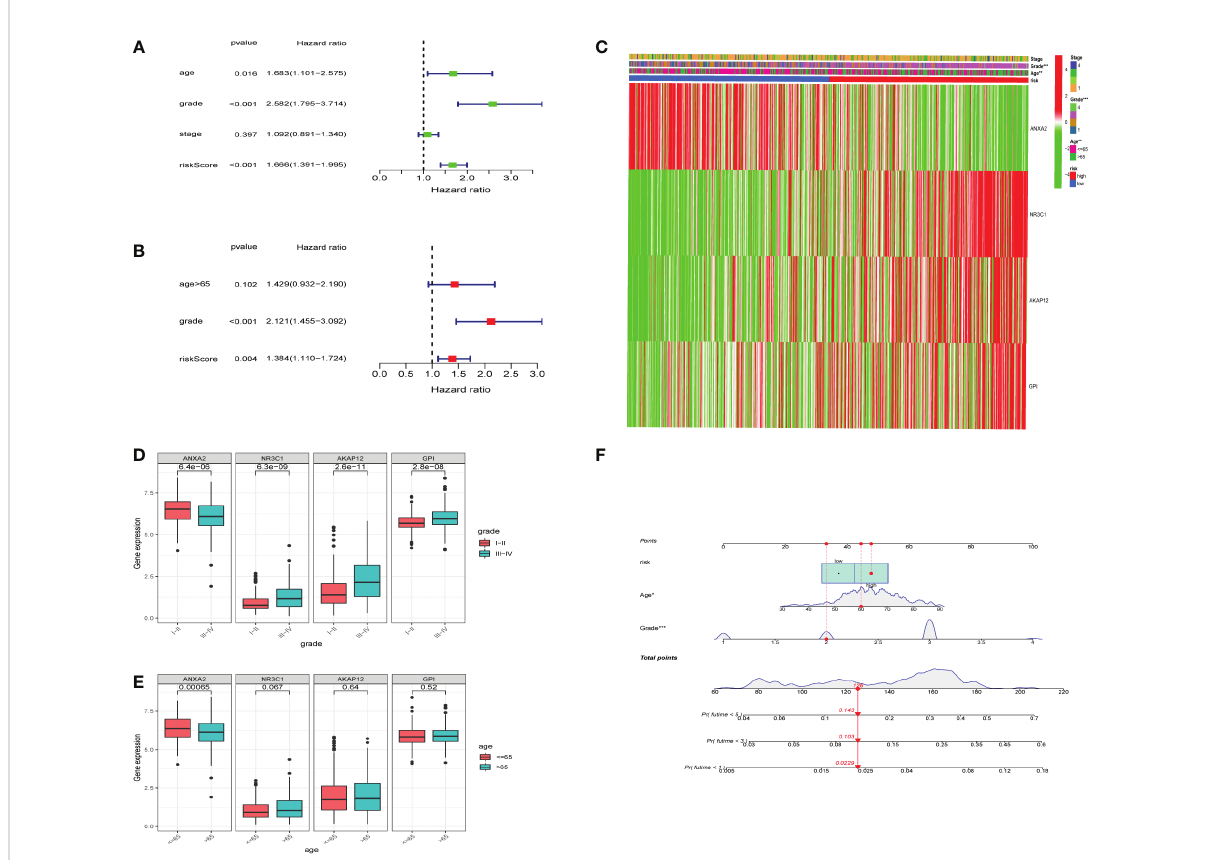
FIGURE 5 Relationship between the risk model and clinical factors. (A) A single-factor prognostic analysis included age, grade, stage, and the risk scores of patients with endometrial cancer. (B) Multifactor prognostic analysis included age, grade, and the risk scores of patients with endometrial cancer. (C) Heatmap (green: low expression; red: high expression) for the connections between clinical characteristics (stages, grades, and ages) of patients in high-risk and low-risk samples. (D, E) Comparisons of the expression levels of various genes in the hypoxia model for different ages and grades. (F) Nomogram based on risk, age, and grade for predicting the prognostic survival rate of patients. * represents a p-value < 0.05, ** represents a p-value < 0.01, *** represents a p-value <